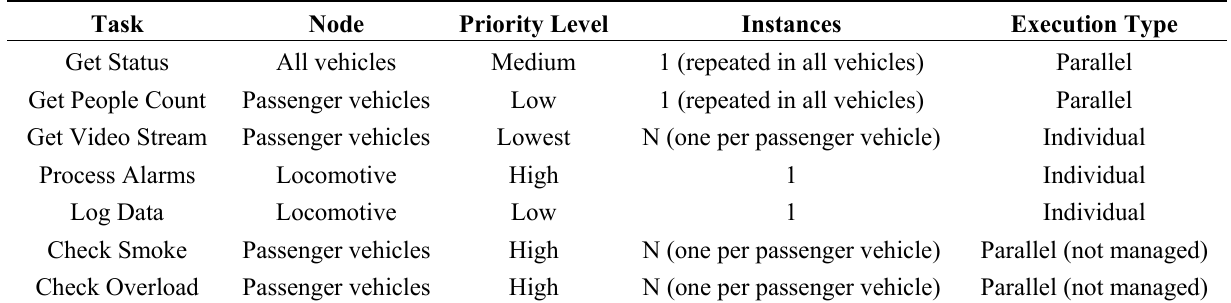
Table 3. Priority values associated to each task.